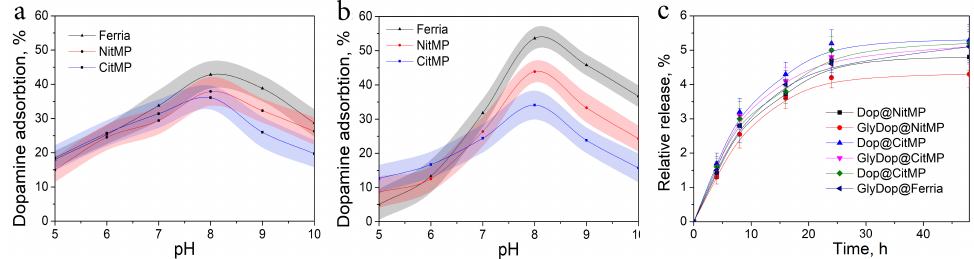
Figure 2. Adsorption of dopamine ( a ) and GlyDop ( b ) on nanoparticles as a function of pH level. ( c ) Stability of the coatings in PBS.